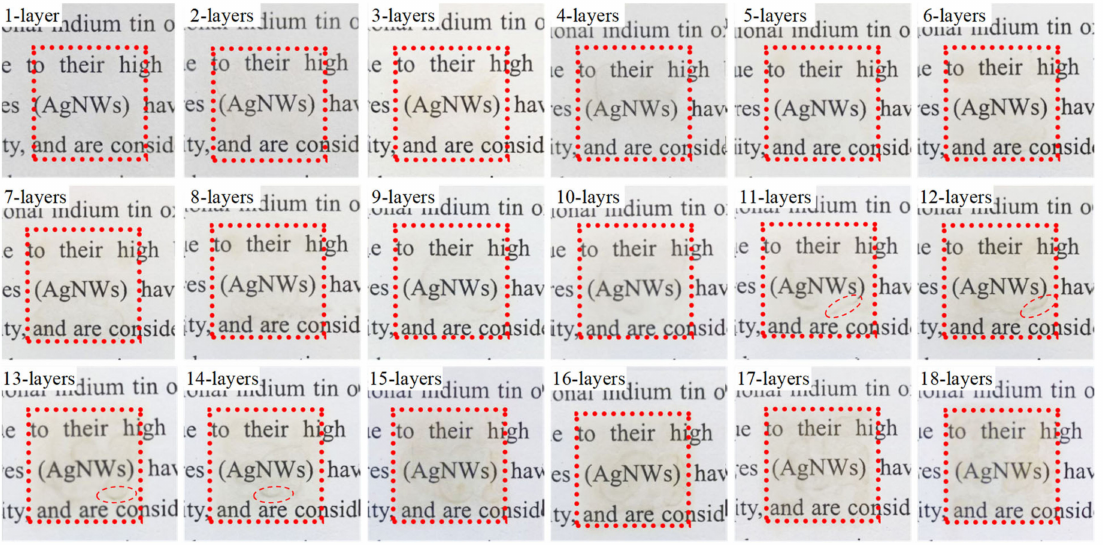
Figure 3. Photographs of printed AgNWs films with 1–18 layers after heat treatment at 80 ◦ C for 10 min, respectively, and the red dotted box is 2 cm × 2 cm in size.